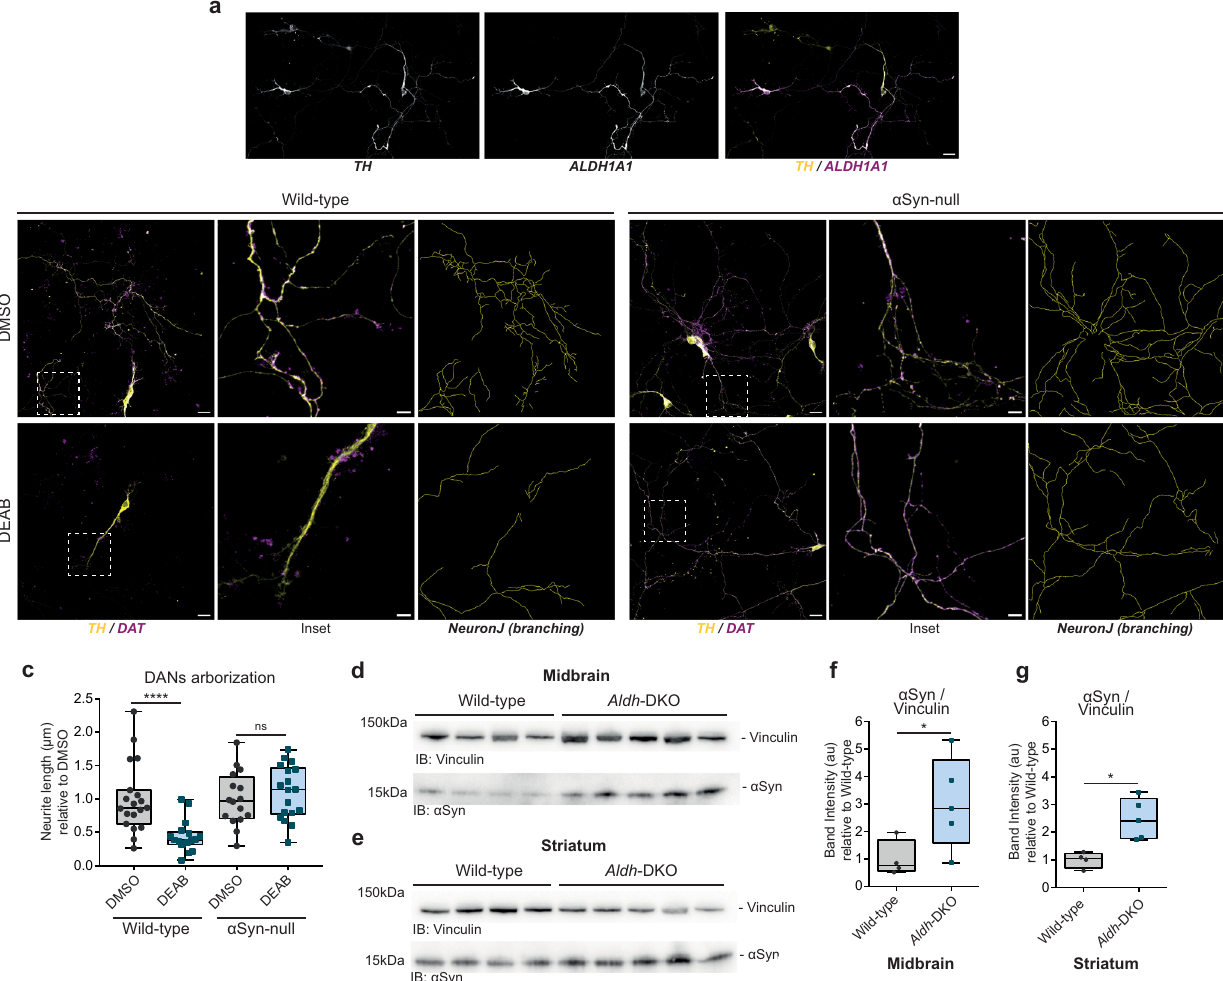
Fig. 7 In vitro and in vivo mouse models of impaired DOPAL detoxi fi cation. a Immunostaining with dopaminergic markers in primary wild- type mouse mesencephalic neurons (DIV11), highlighting the co-localization between TH and ALDH1A1 in DANs. Scale bar: 20 μ m. b Immunostaining with anti-TH and anti-DAT antibodies in primary mesencephalic neurons (DIV11) from wild-type and α Syn-null embryonic mice, after chronic exposure (4 days) to DMSO or 100 nM DEAB. Scale bar: 20 μ m and 5 μ m (in the inset). In the bottom row, the corresponding traces of neurite arborization obtained with NeuronJ. c Quanti fi cation of DANs total neurite length in each fi eld of view. Data from two independent experiments are normalized to each DMSO-treated sample, pooled together, and analyzed by Mann – Whitney test (**** p < 0.0001). Western blot of α Syn levels d , f in the midbrain and e , g in the striatum of 12-month-old wild-type ( n = 4) and Aldh -DKO ( n = 5) mice. Band intensities are normalized to Vinculin as loading control. Data are normalized to the mean value of the wild-type and analyzed by Mann – Whitney test (* p < 0.05). c , f , g Data are displayed as box and whiskers plot showing the minimum and maximum points (whiskers), the fi rst quartile, median and third quartile (box